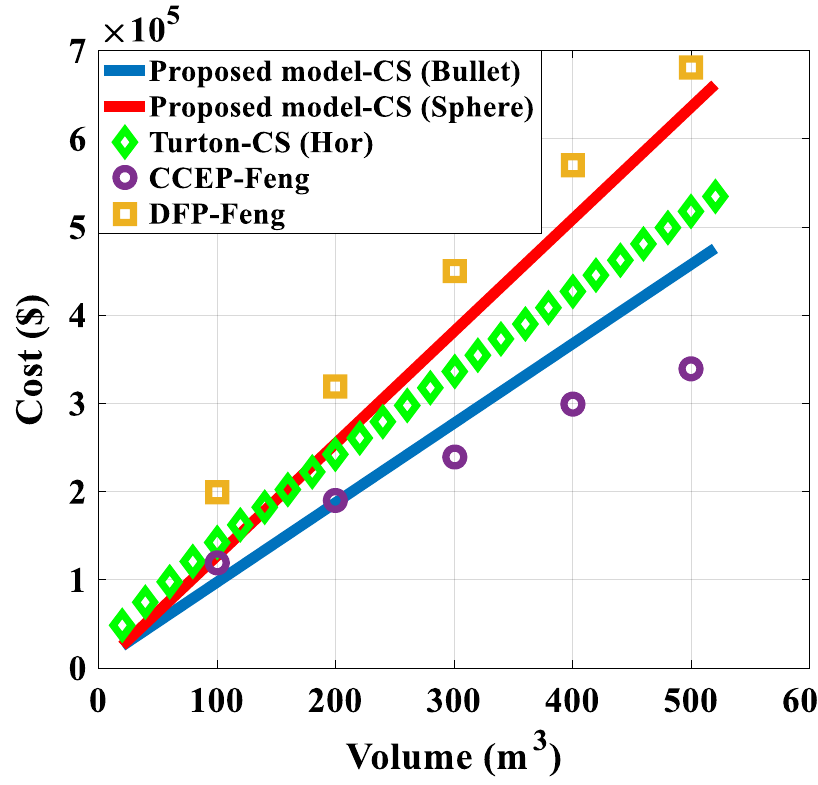
Figure 9. Pressure vessel cost against capacity [28,32].